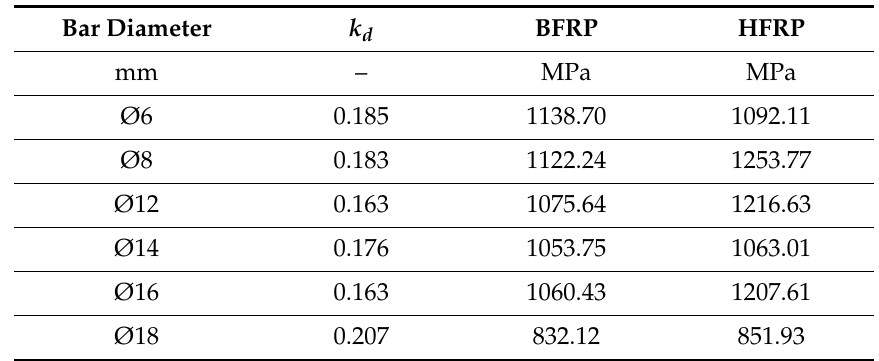
Table 8. Tensile strength calculation according to diameter ratios ( f t = f s / k d ).